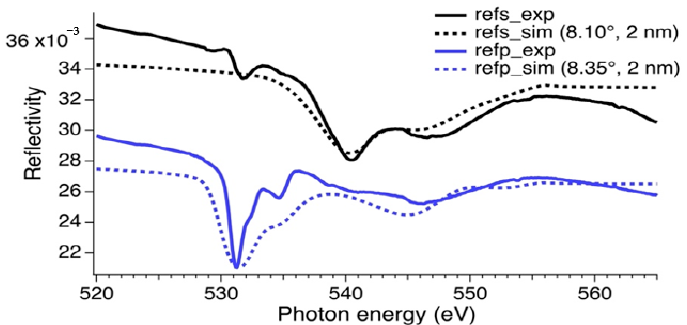
Figure 3. Experimental reflectivity (solid lines) measured at 8° of grazing incidence in s- and p- scattering geometries (labelled as refs and refp, respectively) compared with simulations (broken lines) obtained for a film of flat laying molecules of 2 nm of coverage.